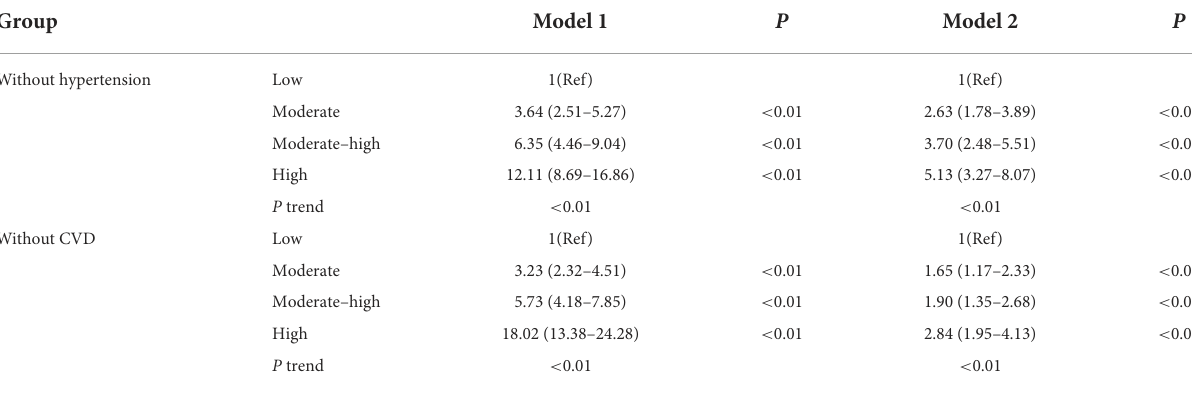
TABLE 5 Cox proportional-hazards model for AF among ePWV groups in different